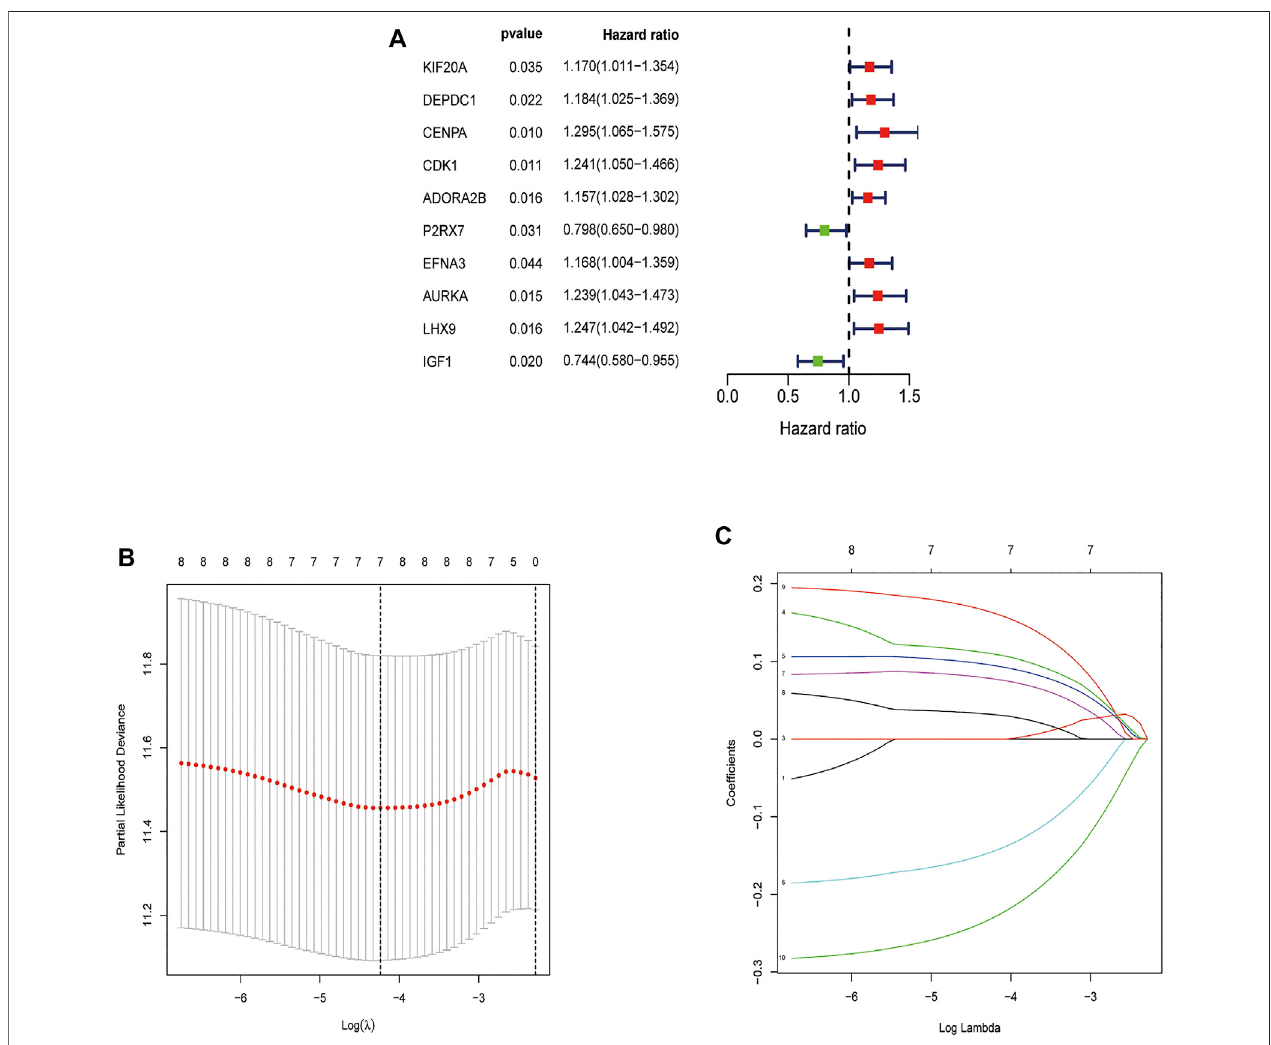
FIGURE 4 | Feature selection using the Univariate Cox analysis and Lasso regression model. (A) Forest map of DEGRGs associated with STS survival, univariate Cox regression, p < 0.01. (B) LASSO coef fi cient spectrum of 7 DEGRGs. (C) On account of 1000 cross-validation for tuning parameter selection via LASSO.